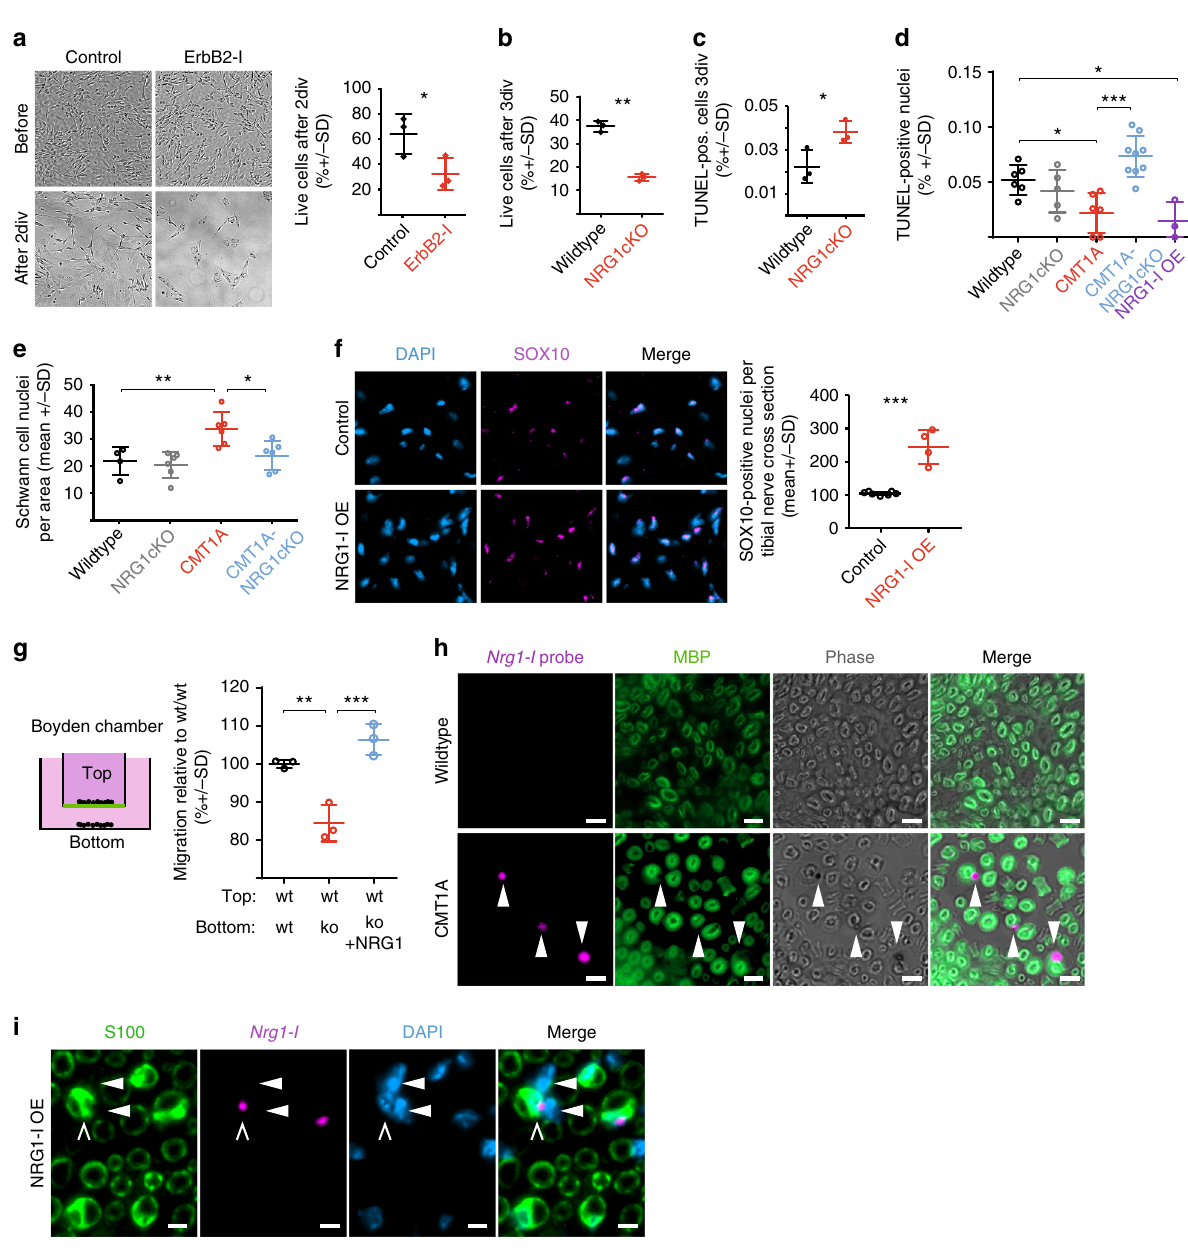
Fig. 4 Schwann cell Nrg1 promotes survival and migration of Schwann cells. a Survival assay with primary rat Schwann cells after 2 days in vitro (2div) with or without an ErbB2 inhibitor (CAS 928207-02-7, 30 µ M). Representative before/after pictures (left panels) with quanti fi cation (right panel; a – c : n = 3 independent Schwann cell preparations per group, paired Student ’ s T test). b Survival assay with primary mouse Schwann cells from wild-type and NRG1cKO mice after 3div. c In the same experiment as in b , the apoptosis rate was assessed by terminal deoxinucleotidyl transferase-mediated dUTP- fl uorescein nick end labeling (TUNEL) assay. d Quanti fi cation of Schwann cell apoptosis as measured by percentage of TUNEL-positive nuclei on sciatic nerve longitudinal sections from 11-day-old mice (wild type n = 6, NRG1cKO n = 5, CMT1A n = 6, CMT1A-NRG1cKO n = 9, NRG1-I OE n = 3, one-way analysis of variance (ANOVA), Tukey ’ s post test). e Quanti fi cation of Schwann cell nuclei per area (15,740 µ m 2 ) on electron micrographs of 4-month-old wild type ( n = 4), NRG1cKO ( n = 6), CMT1A ( n = 6), and CMT1A-NRG1cKO ( n = 6) mice (one-way ANOVA and Tukey ’ s post test). f Fluorescent immunohistochemistry on tibial nerve cross-sections from 4-month-old control ( n = 4) and Neuregulin-1 type 1 (NRG1-I) overexpression (OE) ( n = 3) mice against SOX10 (left panels) and respective quanti fi cation (right panel, Student ’ s T test). g Schematic set-up of Boyden chamber migration experiments (left panel) and respective quanti fi cation (right panel) of the percentage of cells that migrated from the top compartment through the mesh (green in left panel). The top compartment was always seeded with wild-type (wt) Schwann cells, whereas in the bottom compartment either with wild type (wt, black, set to 100%) or NRG1cKO Schwann cells were seeded and the latter without (ko, red) or with (ko + NRG1, blue) recombinant NRG1 (quanti fi cation of three independent experiments, one-way ANOVA, Tukey ’ s post test). h BaseScope TM in situ hybridization with a Nrg1-I probe (magenta) on sciatic nerve cross- sections of 18-day-old wild-type and CMT1A mice. Myelin was counterstained with MBP (green) and together with the phase contrast demonstrates Nrg1-I expression in myelinating Schwann cells in the CMT1A mouse (arrows, scale bar 5 µ m). i BaseScope in situ hybridization with a Nrg1-I probe (magenta) on sciatic nerve cross-sections of a 4-month-old NRG1-OE mouse showing expression of Nrg1-I (magenta) in Schwann cells (S100, green). Note that supernumerary Schwann cells (closed arrows) are located nearby a Nrg1-I -expressing myelinating Schwann cell (open arrow, scale bar 5 µ m, DAPI: nuclei). Source data are provided as a source data fi le. All respective p values are depicted as a range of signi fi cance with * p < 0.05; ** p < 0.01; and *** p <